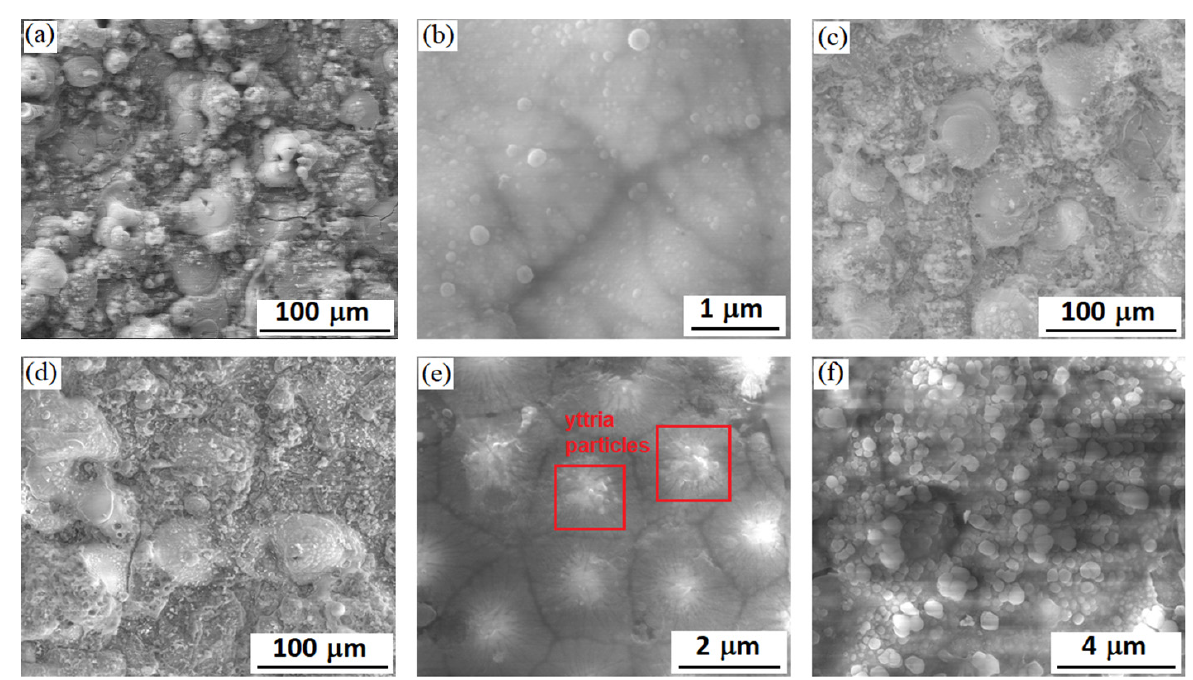
Figure 2. SEM images in the mode of backscattered electrons of surface morphology: PEO coatings formed at current densities 20 ( a ), 30 ( c ), and 40 ( d ) A/dm 2 ; submicron yttria particles on the surface of coatings formed at current densities 20 ( b ) and 40 A/dm 2 ( e , f ).